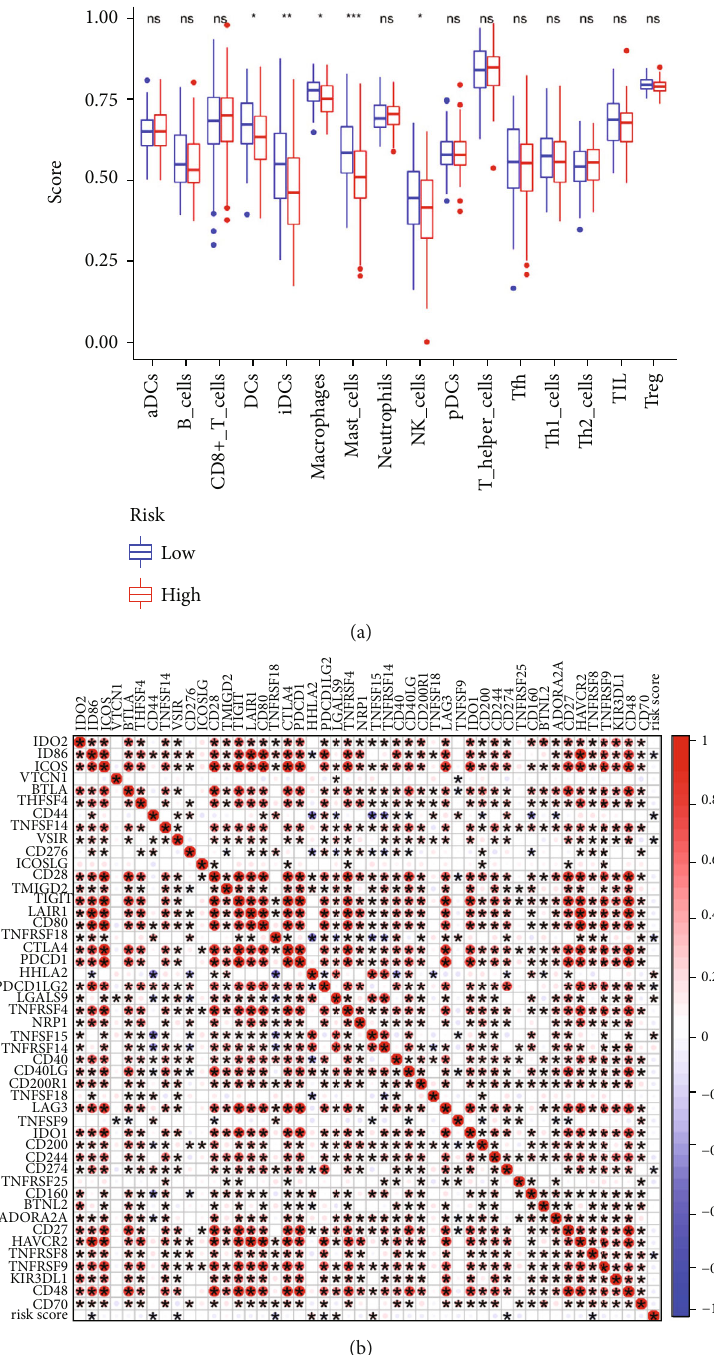
Figure 4: MAIP1 correlated with the immune cell in fi ltration and immune checkpoint-related genes in EC. (a) In fi ltration level of various immune cells in MAIP1 high and MAIP1 low groups. (b) Pro fi le of correlation between the immune checkpoint-related genes or and risk scores in